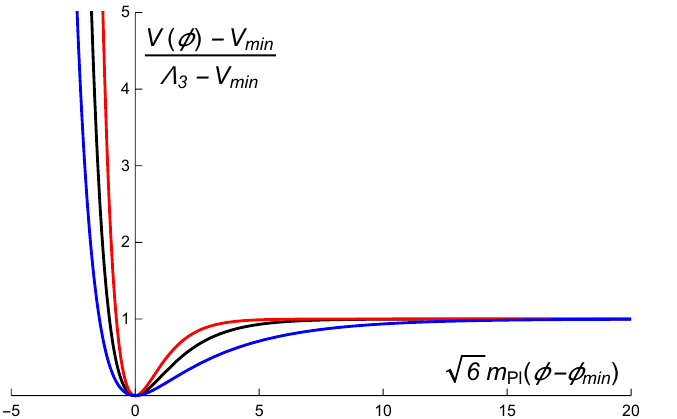
Figure 1. Graphics of the potential (4) for λ = 2 (corresponding to the Starobinski model (3)) and µ 3 taking the values 1 (black line, also corresponding to the Starobinski model), 0.65 (red line) and 0.15 3 (blue line). The axes origin is ( φ min , V min ) with φ min being the inflaton value at which the potential takes its minimum and V min : = V ( φ min )